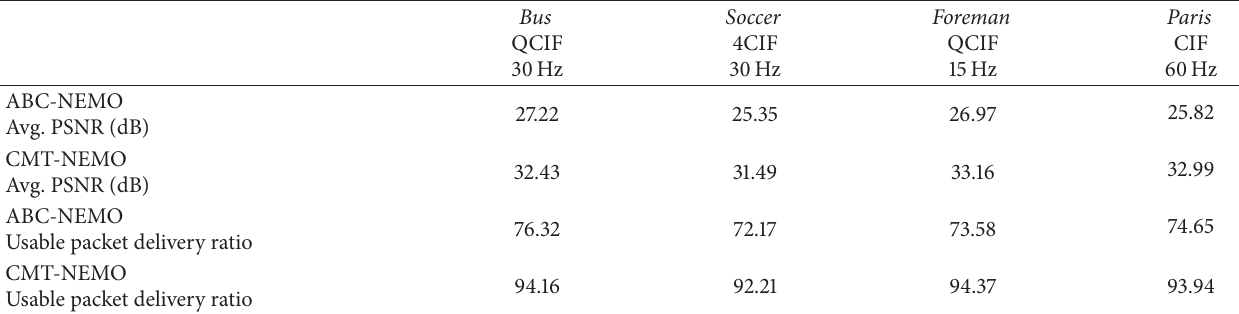
Table 2: Average PSNR and packets delivered for additional sequences.